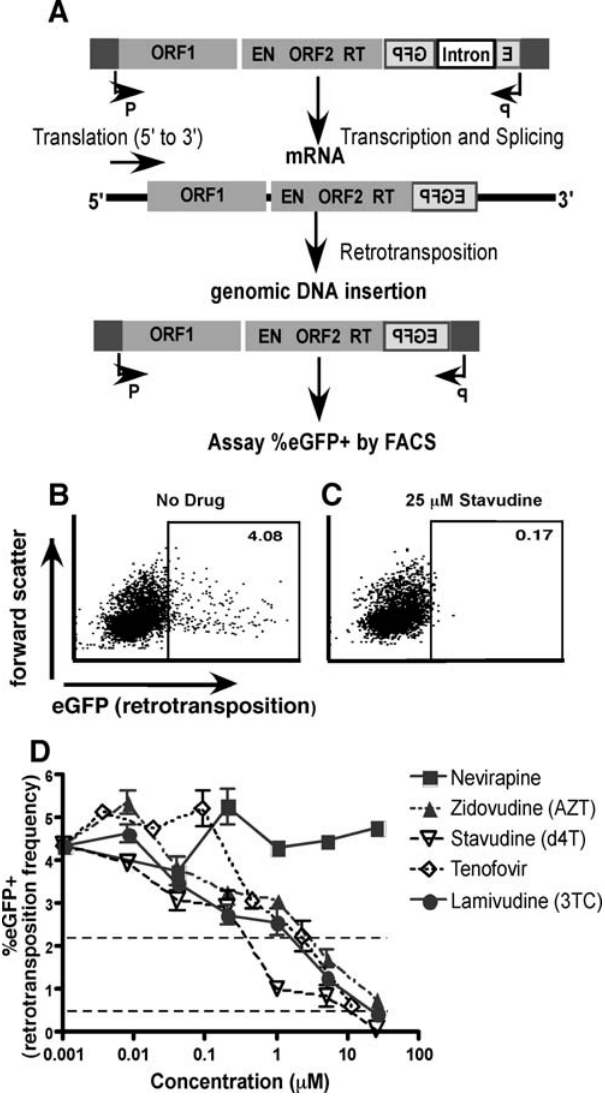
Figure 1. Effect of antiretroviral drugs on LINE-1 retrotrans- position frequency. A. The LINE-1 retrotransposition reporter plasmid 99gfpLRE3 encodes the full-length, retrotransposition compe- tent LRE3 LINE-1 element under the control of its natural promoter.